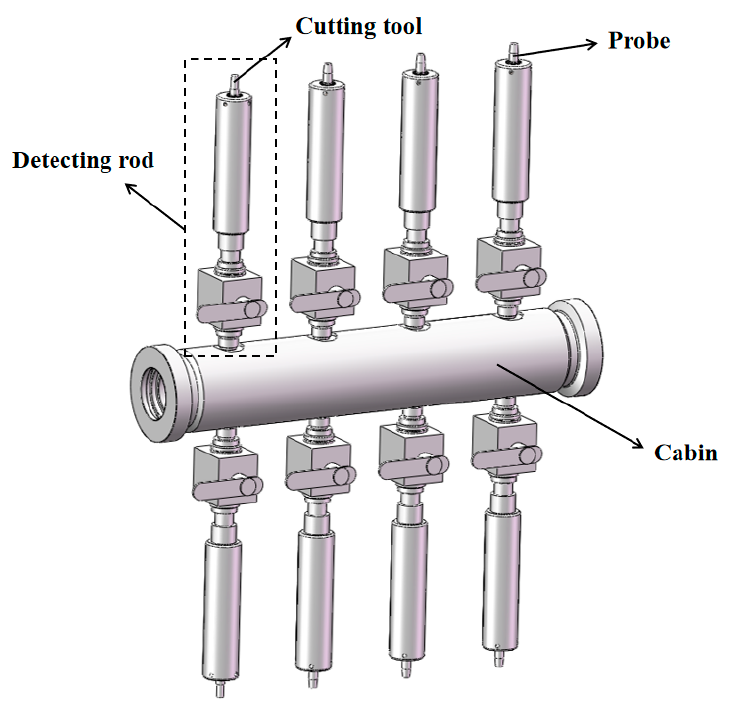
Figure 1. Marine sediment resistivity measuring instrument.